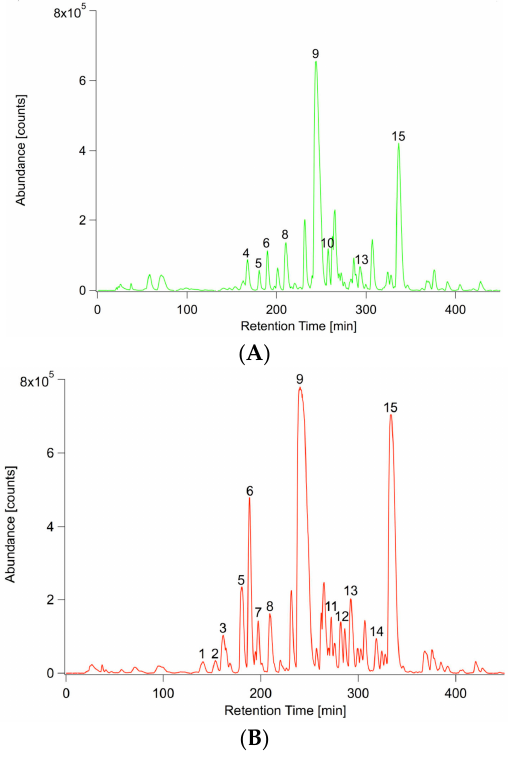
Figure 7. Representative UPLC/ESI( − )-QTOFMS base peak chromatograms ( m / z 100–1000) of inoculated and non-inoculated A. thaliana root extracts. ( A ) Non-inoculated root; ( B ) with P. indica inoculated root. 1 : 7MeSO Heptyl GSL; 2 : 2,5 DHBA-Pent; 3 : I3M GSL; 4 : C 14 H 18 O 10 ; 5 : C 17 H 24 O 10 ; 6 : 8 MeSO Octyl GSL; 7 : Scopolin; 8 : 4MeO-I3M GSL 9 : 1MeO-I3M GSL; 10 : C 18 H 32 O 11 ; 11 : C 19 H 18 O 3 ;